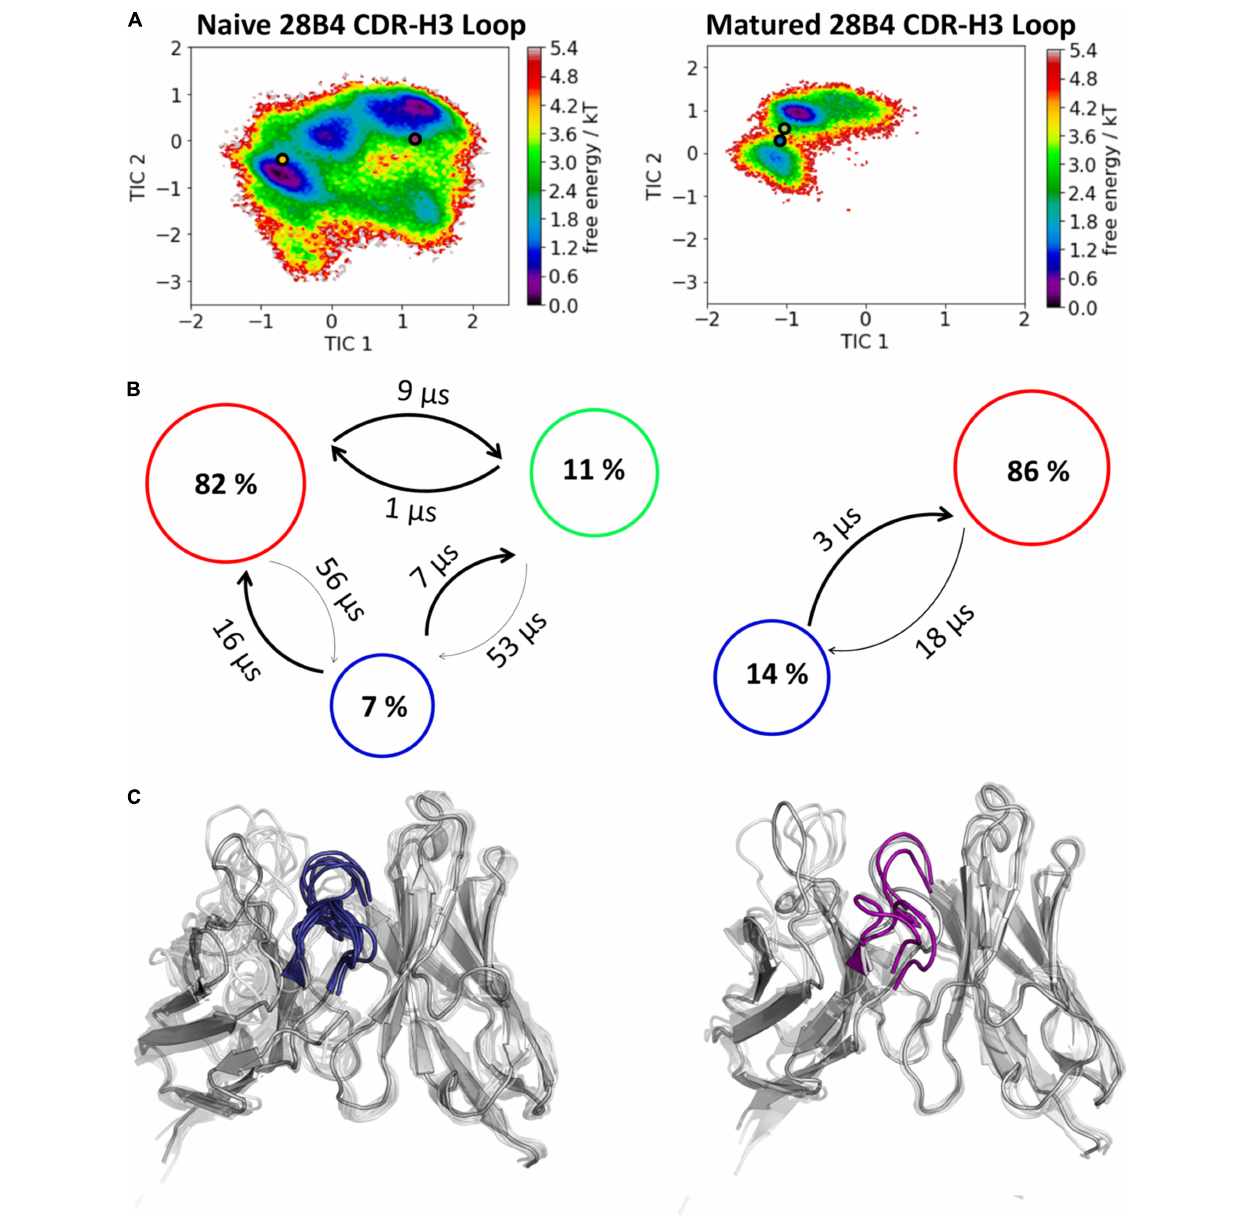
FIGURE 4 | Kinetic, thermodynamic and structural analyses of the CDR-H3 loop ensemble in solution upon affinity maturation. (A) Free energy surface of the naive and matured 28B4 Fab in the same coordinate system, including the respective X-ray structures crystallized with and without antigen. The orange and green dots show the bound X-ray structures of the naïve and the matured Fab, respectively, while magenta and blue display the X-ray structures crystallized without antigen. (B) Transition timescales between the different macrostates orientated according to the tICA space including the state probabilities. (C) Substantial decrease of the conformational ensemble of the 28B4 antibody upon affinity